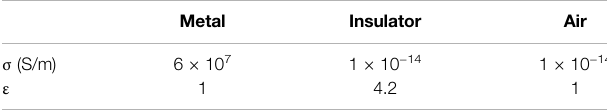
TABLE 1 | Electrical conductivity and relative permittivity con fi guration of different